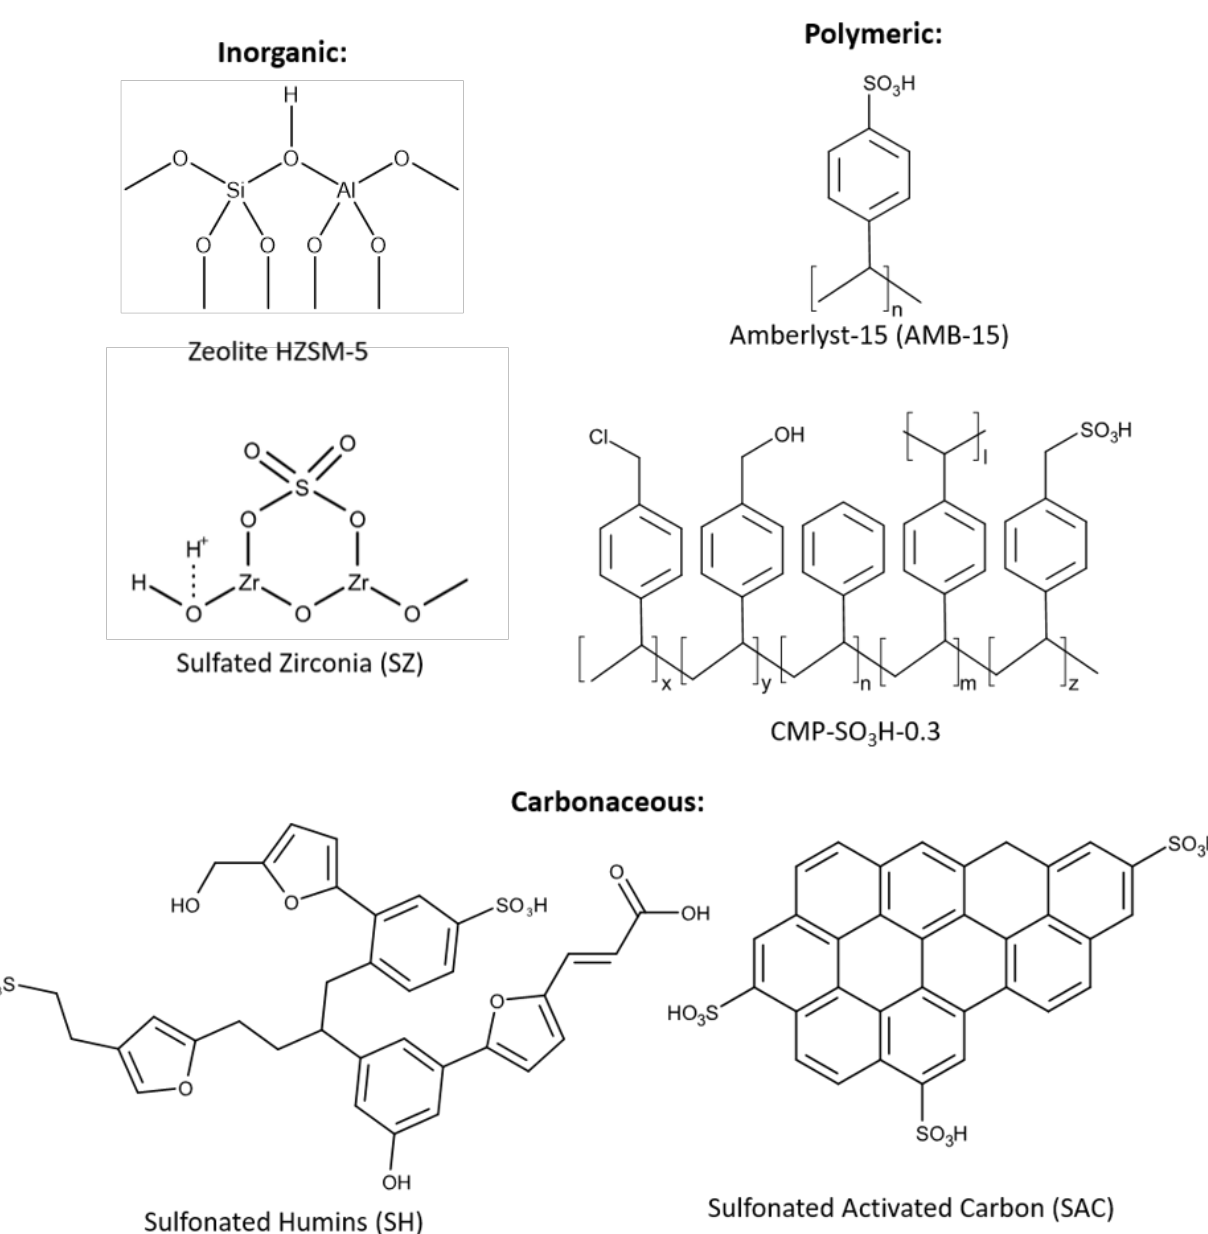
Figure 1. Simplified structures of the solid acid catalysts used in the current study [33,35,70 – 73].